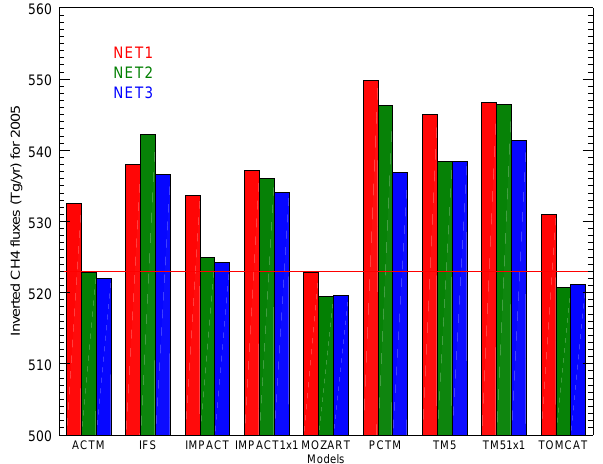
Fig. 14. Global methane estimates for every inversion using TransCom model outputs as synthetic observations in three network configurations. Results for NET1, NET2 and NET3 are respectively represented in red, green and blue. The red line shows the target value of the methane flux at the global scale (523Tgyr − 1